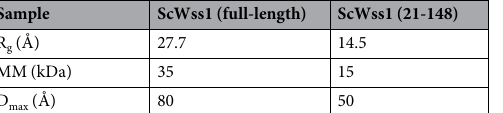
Table 2. Overall parameters of the full-length ScWss1 calculated from the SAXS data and the theoretical structural parameters of ScWss1 21-148 calculated from the crystallography values, including the radius of gyration ( R g ), molecular mass ( MM ) and maximum diameter ( D max